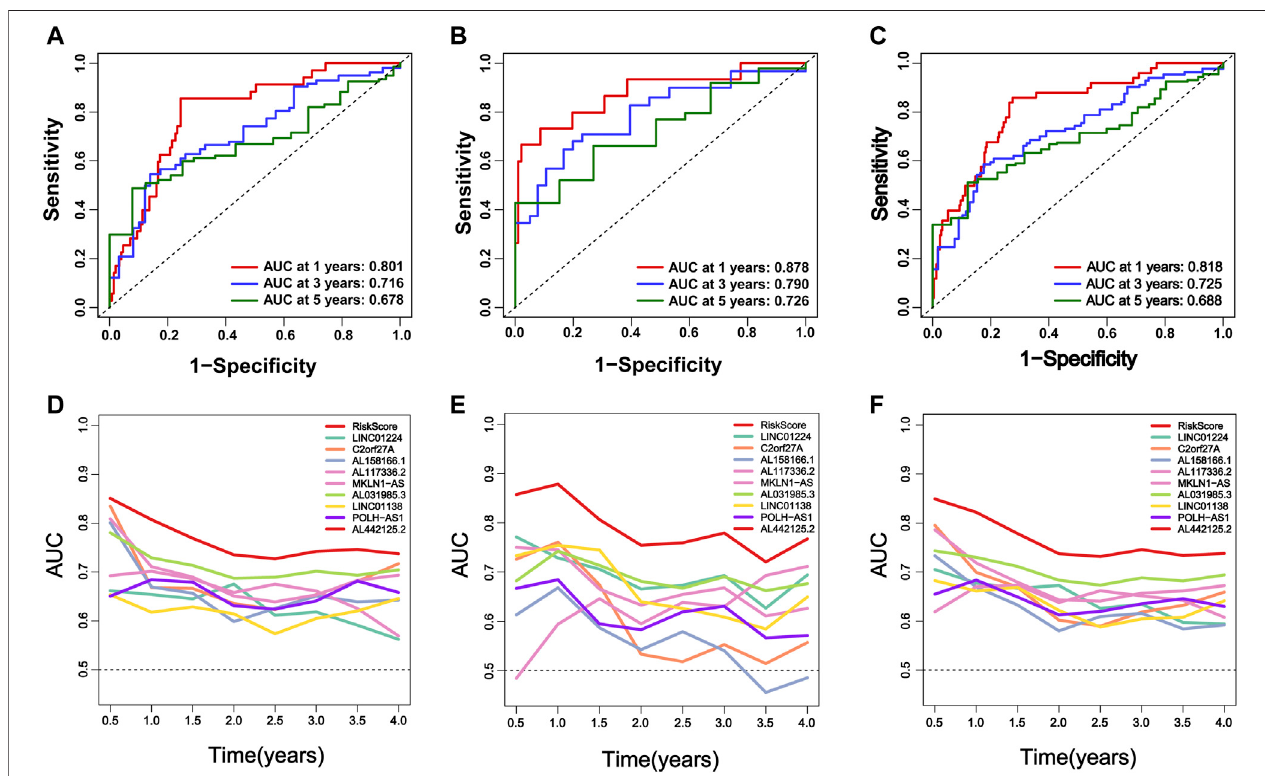
FIGURE 5 | M6A-9LPSpredictsthe ef fi ciency ofOSin patientswith HCC intraining, validation, and the entire cohort. (A – C) The time-dependent ROC curve analysis veri fi ed the ef fi ciency of m6A-9LPS in predicting 1-year, 3-year, and 5-year survival rates in the training, validation, and entire TCGA cohort. (D – F) The time-dependent AUC value graph compared the predictive ef fi ciency between m6A-9LPS and known prognostic markers in the training cohort, validation, and entire TCGA cohort.